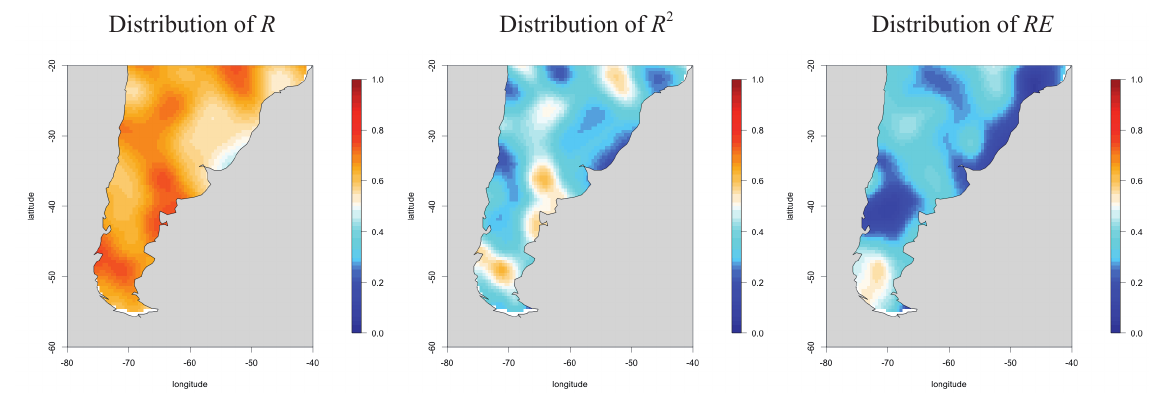
Figure 5. Distribution of R, R 2 , and RE statistics in SSA. These calibration and validation statistics were caclculated on the full set of proxies, and the data was interpolated with a thin-plate spline regression.